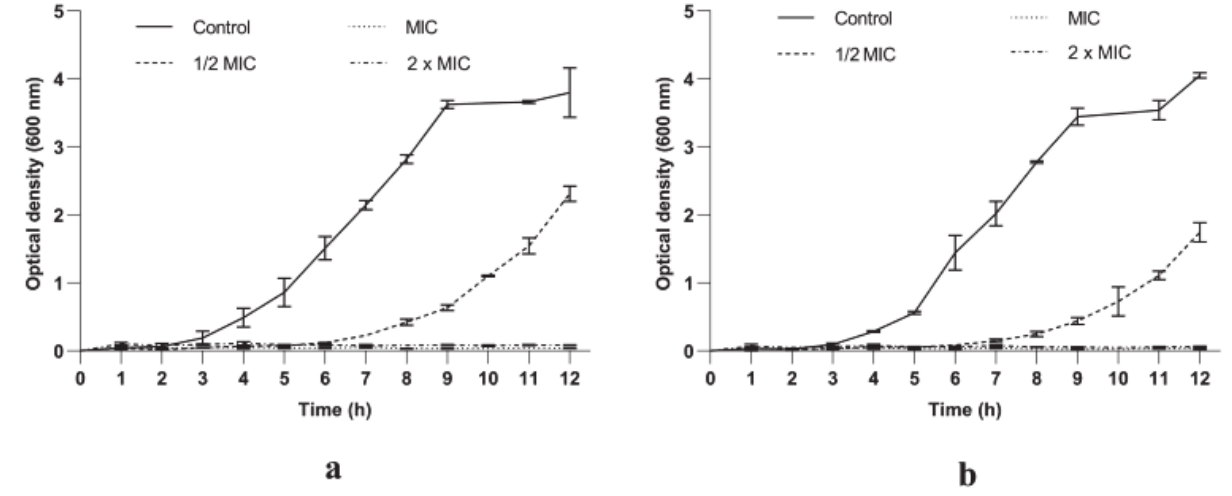
Figure 2. Growth kinetics of S. aureus ATCC 25923 treated with extracts PlLm ( a ) and PlLe ( b ) at different concentrations. Bars indicate standard deviations.